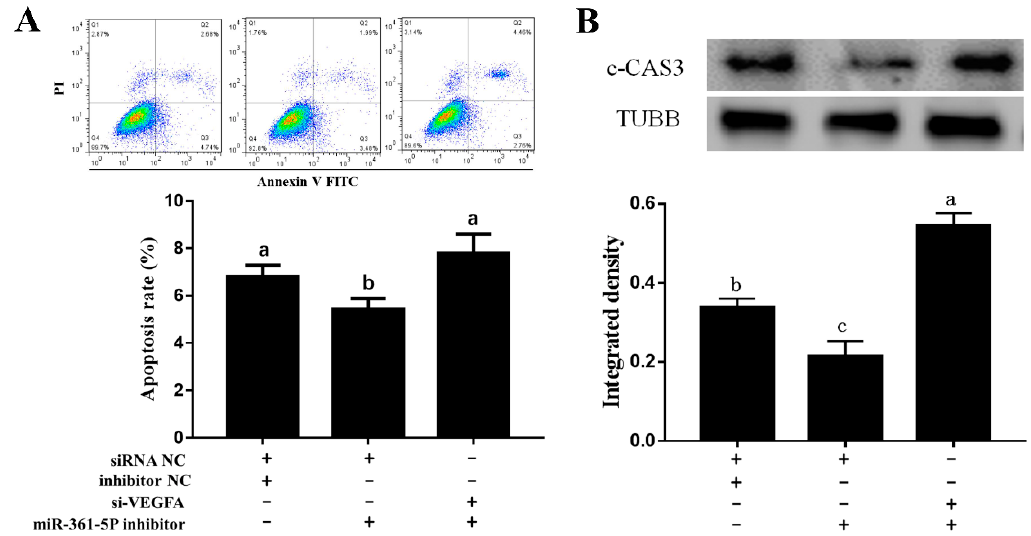
Figure 4. miR-361-5p regulates GC apoptosis through VEGFA. ( A ): GC apoptosis rate decreased after the transfection of miR-361-5p inhibitor and reversed after the addition of VEGFA siRNA detected by FACS analysis. ( B ): The protein levels of cleaved caspase 3 (c-CAS3) was down-regulated after the transfection of the miR-361-5p inhibitor and reversed after the addition of VEGFA siRNA. Plus ( + ) indicates addition of siRNAs or inhibitors, minus ( − ) indicates no addition of siRNAs or inhibitors. Data are expressed as the mean ± SEM. Significant differences ( p < 0.05) are indicated by different letters.